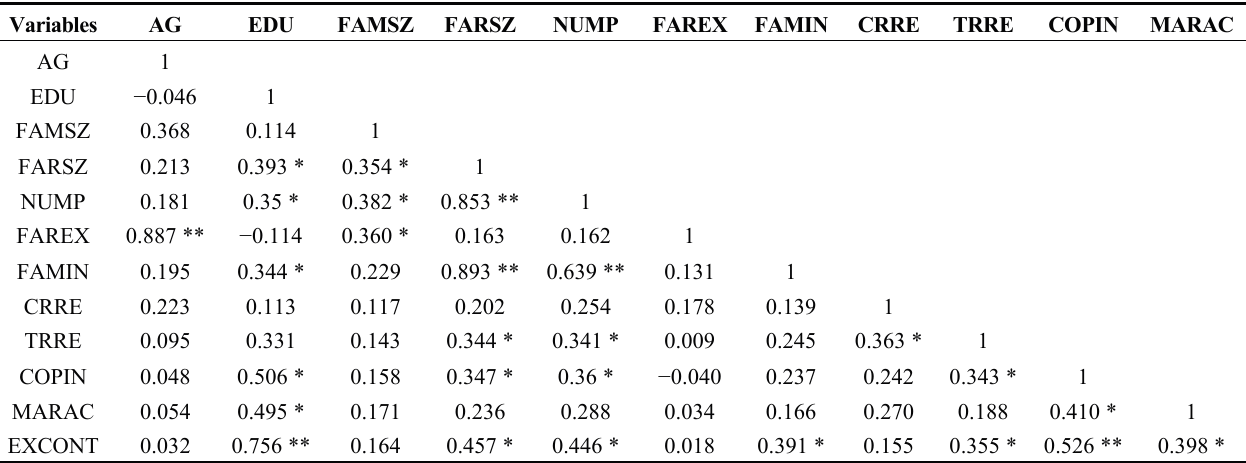
Table 4. Contingency coefficient test for co-linearity between independent variables.